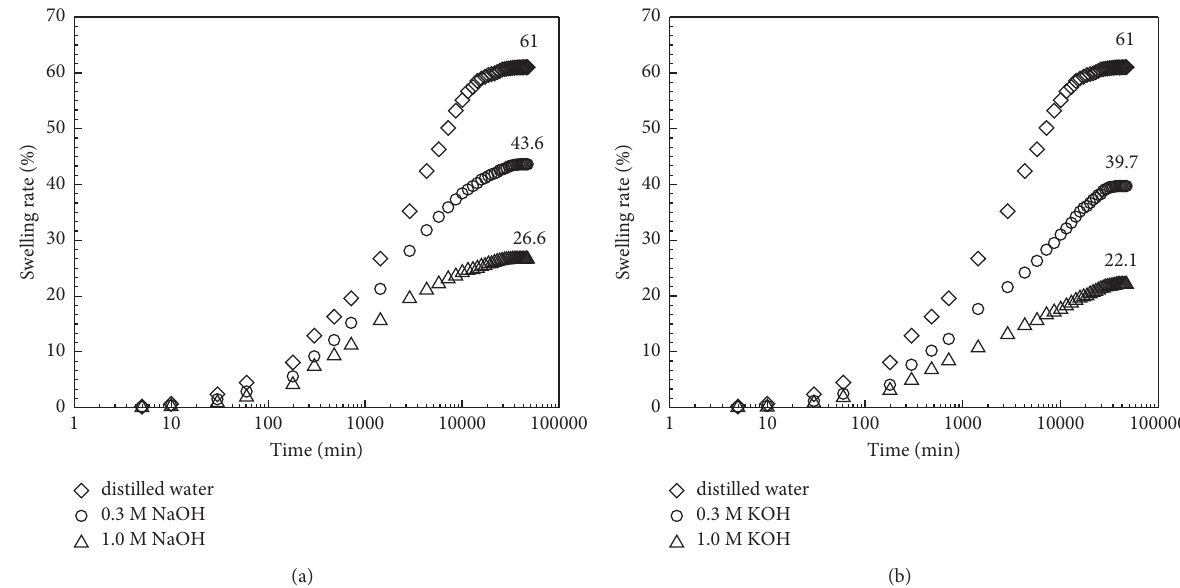
Figure 1: The relationship curve of bentonite swelling rate and time under 100kPa.